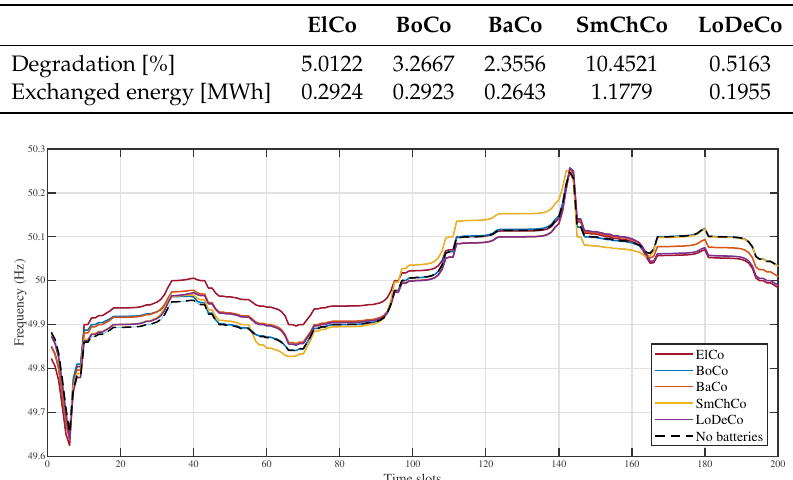
Table 1. Degradation of the battery and energy exchanged with the power grid.